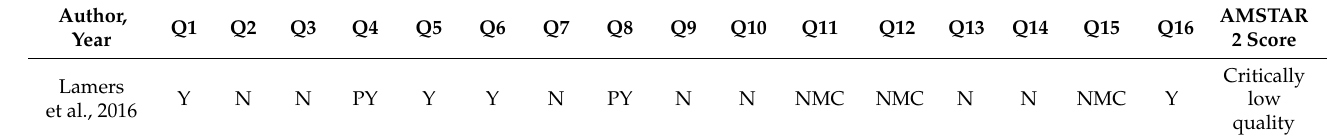
Table 3. Quality assessment of the systematic review that was included using the AMSTAR 2